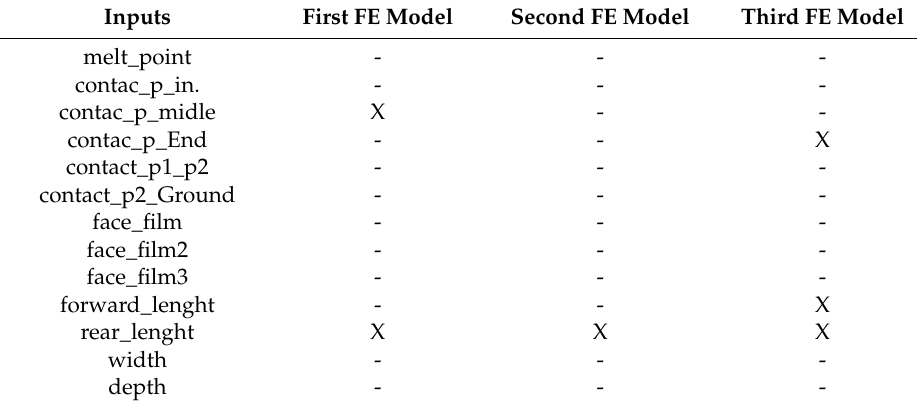
Table 4. Results of using the correlation based feature selection (CFS) technique to analyze the relationship between the output feature or objective function J Totalj and the input